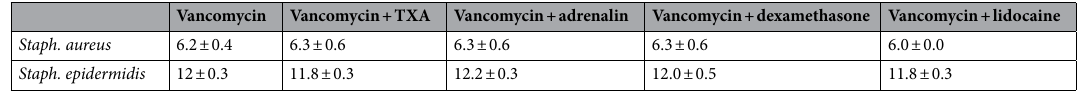
Table 2. Zone of inhibition of the different substances in mm. TXA, adrenalin, dexamethasone, and lidocaine did not inhibit bacterial growth at